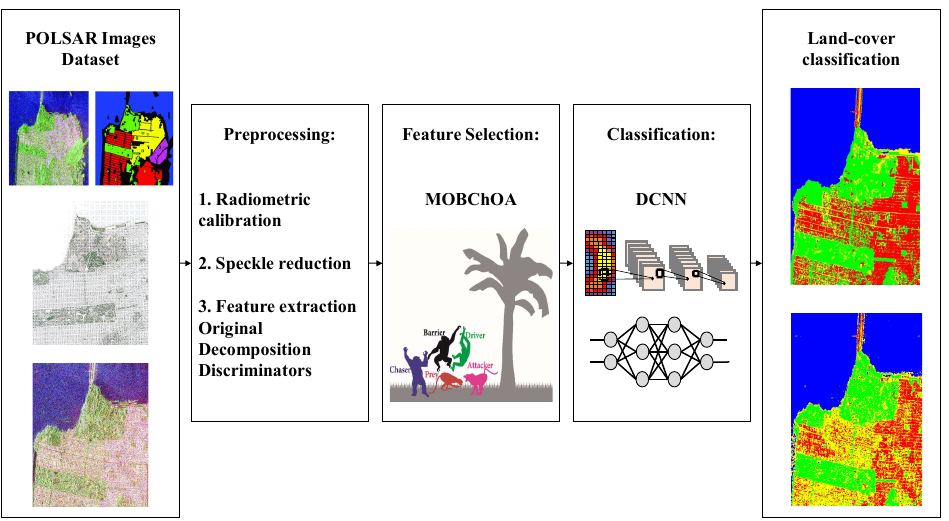
Figure 1. The flowchart of the research method.